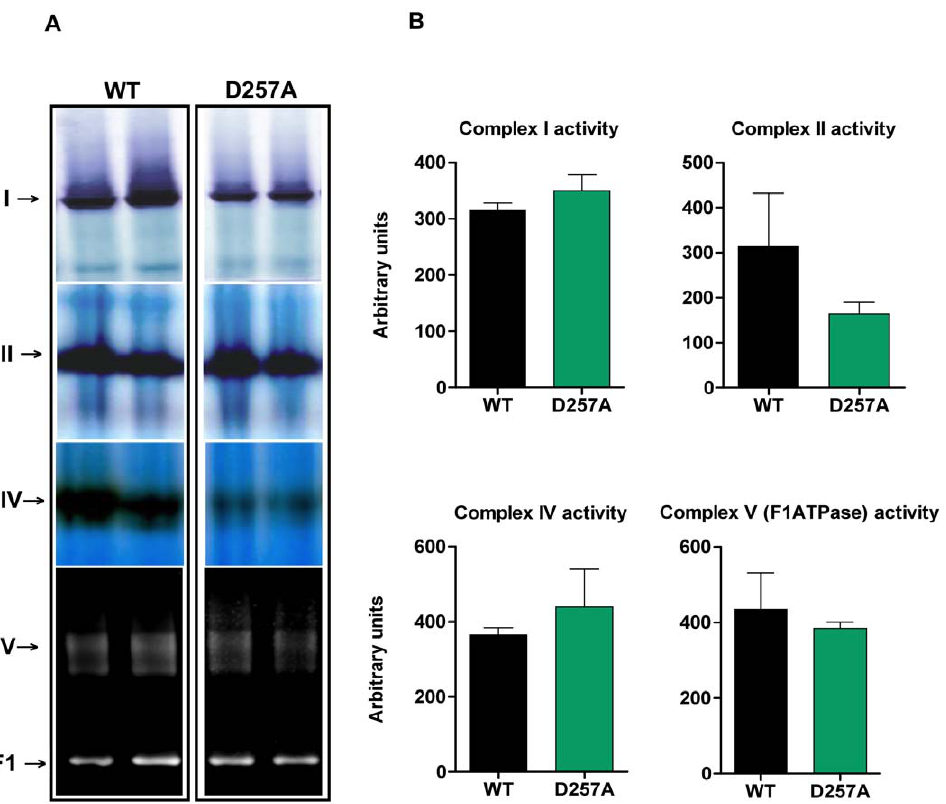
Figure 5. No differences between WT and D257A mice in ETC complexes I, II, IV and F1-ATPase specific activity. (A) The activity of ETC complexes I, II, IV and the F1 domain of the ATPase, in skeletal muscle of 11-mo old WT and D257A mice (n=7 per group), was determined using Blue Native PAGE, followed by enzymatic colorimetric reactions performed on the gels. Representative blots are depicted. (B) Statistical analysis of ETC complexes specific activity. Arbitrary units represent activity densitometry values normalized to respective content densitometry values for each sample. No statistically significant differences were observed. Mean values 6 SEM are shown.